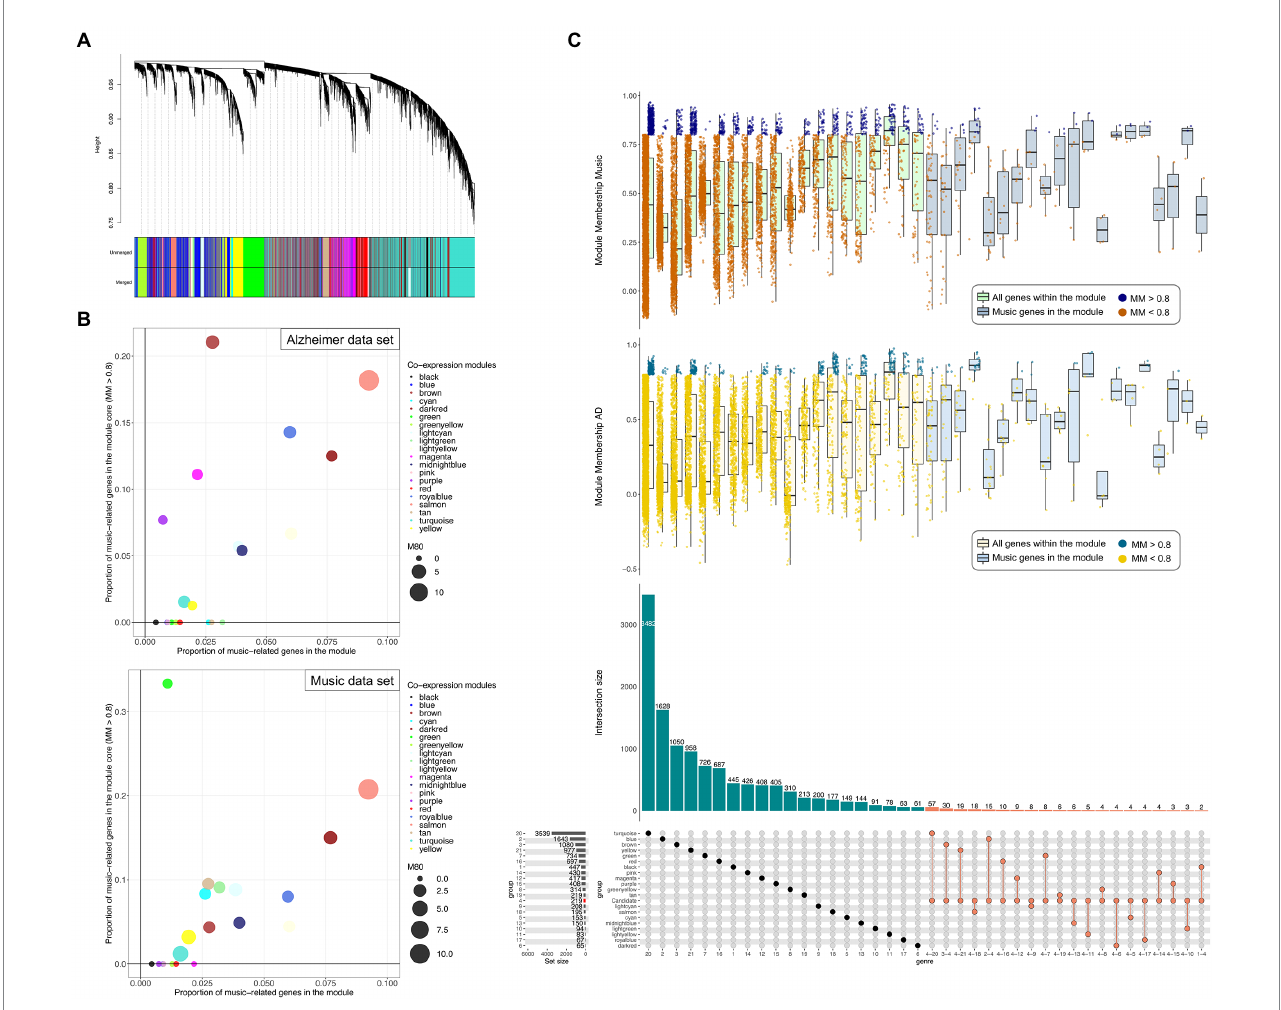
FIGURE 5 (A) Clustering dendrogram of genes and co-expression consensus modules detected, represented by different colors. (B) Scatter plots representing the proportion of music-related genes in the module core (Module membership [MM] > 0.8) against the proportion of music-related genes in the module. Size of the points is proportional to the number of genes in the core of the module (MM > 0.8). (D) Upset plot showing the proportion of music-related candidate genes included in the consensus modules (bottom). Boxplots (top) representing the MM value of the genes from each module from both the AD and music dataset, and horizontally separated in those included and not included in the music-related